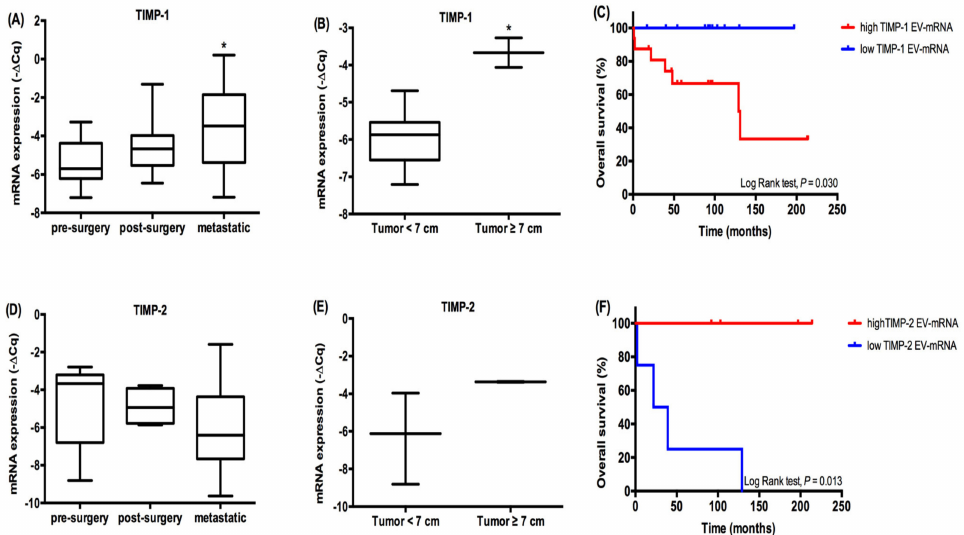
Figure 4. EV-derived TIMP-1 and TIMP-2 mRNA expression in ccRCC plasma samples. EV-derived TIMP-1 ( A ) and TIMP-2 ( D ) mRNA expression in patients with localized disease (pre- and post-surgery) and metastatic disease. EV-derived TIMP-1 ( B ) and TIMP-2 ( E ) mRNA expression in patients with localized with tumor < 7 cm and ≥ cm. Overall survival of metastatic ccRCC patients according to EV-derived TIMP-1 (high expression levels n = 16, low expression levels n = 11) ( C ) and TIMP-2 (high expression levels n = 4, low expression levels n = 4) ( F ); mRNA expression (Mean ± Std. Error; * p < 0.05, ** p <